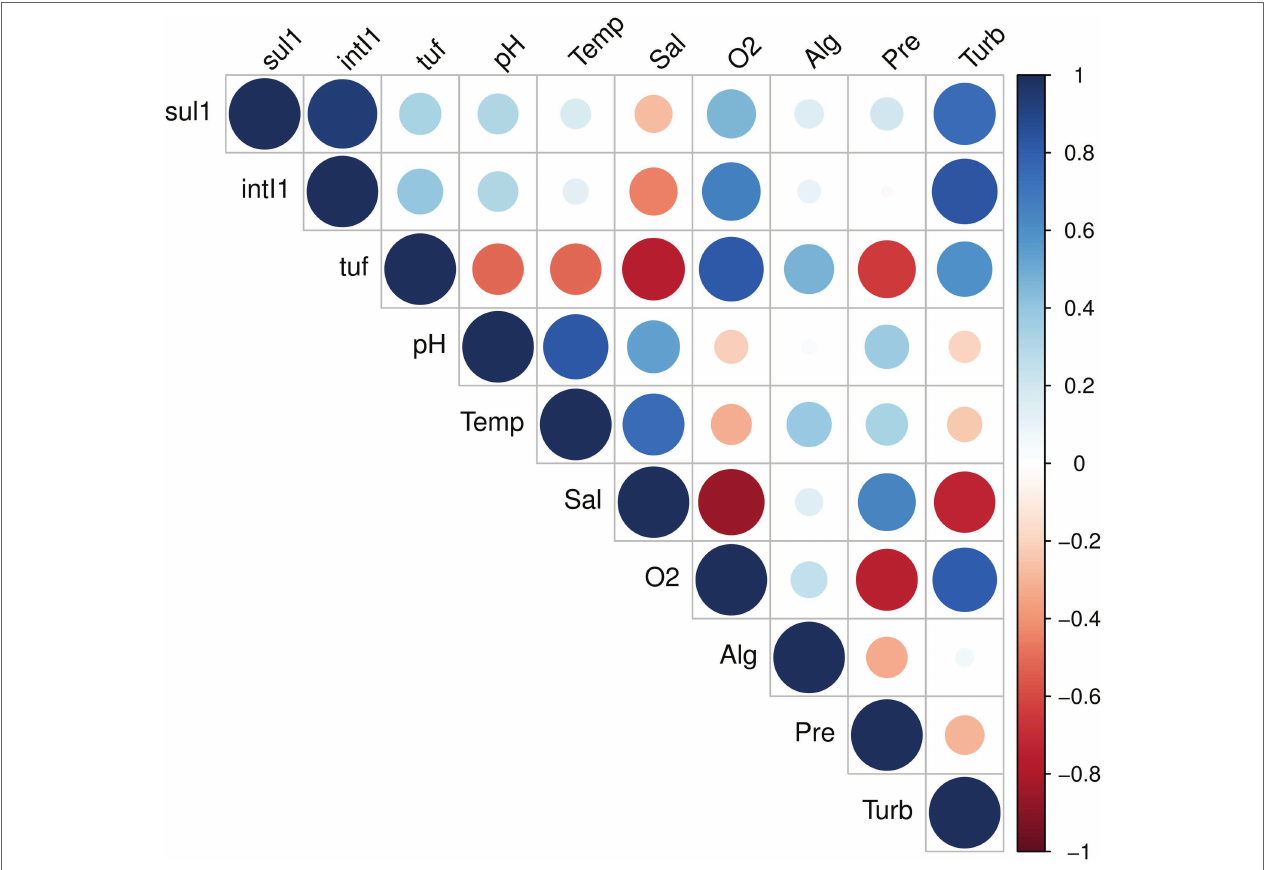
FIGURE 5 | Pearson correlation matrix between the sul1 and intI1 indicator genes, the tuf gene and the environmental variables. Temp, temperature; Sal, salinity; O 2 , dissolved oxygen; Alg, algal biomass; Pre, pressure; and Turb, turbidity. The color key indicates the correlation coefficients and corresponding